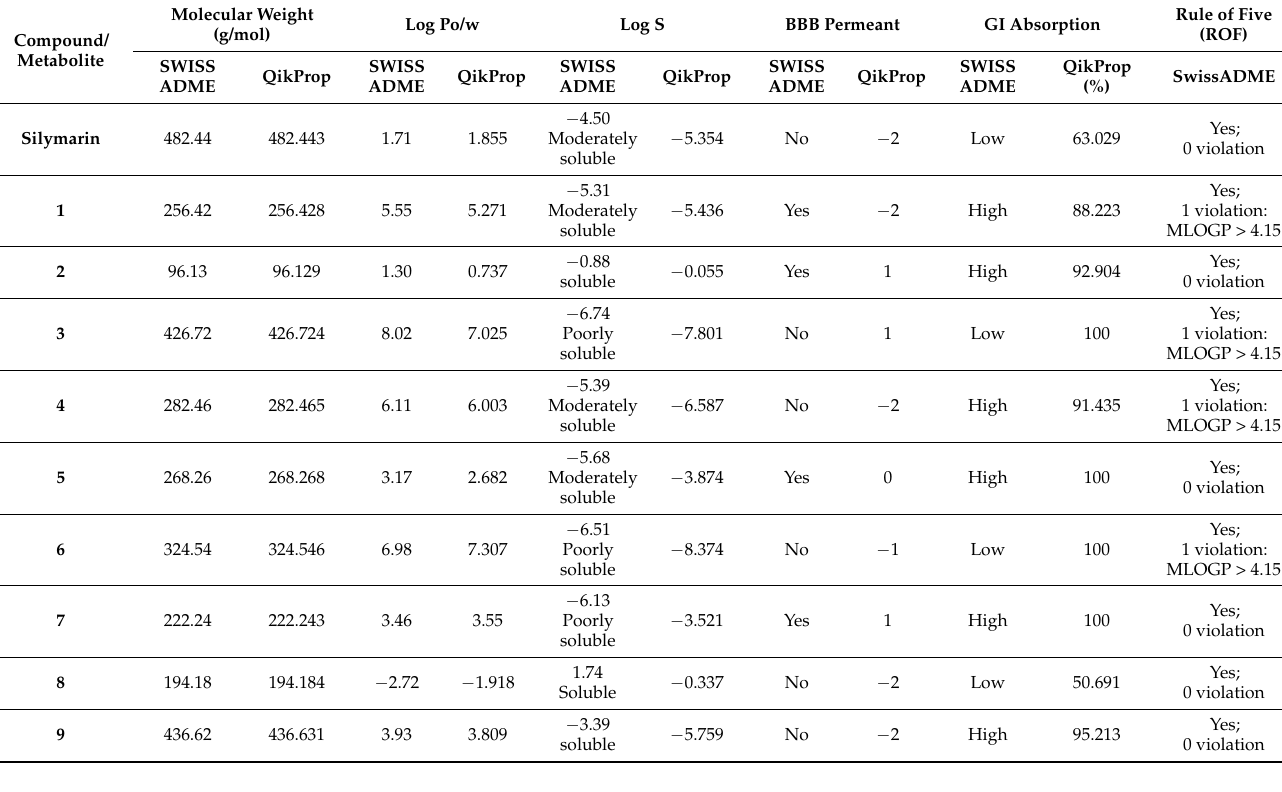
Table 4. Predicted ADME properties for identified bioactive BERM-derived metabolites using SwissADME and QikProp tools.